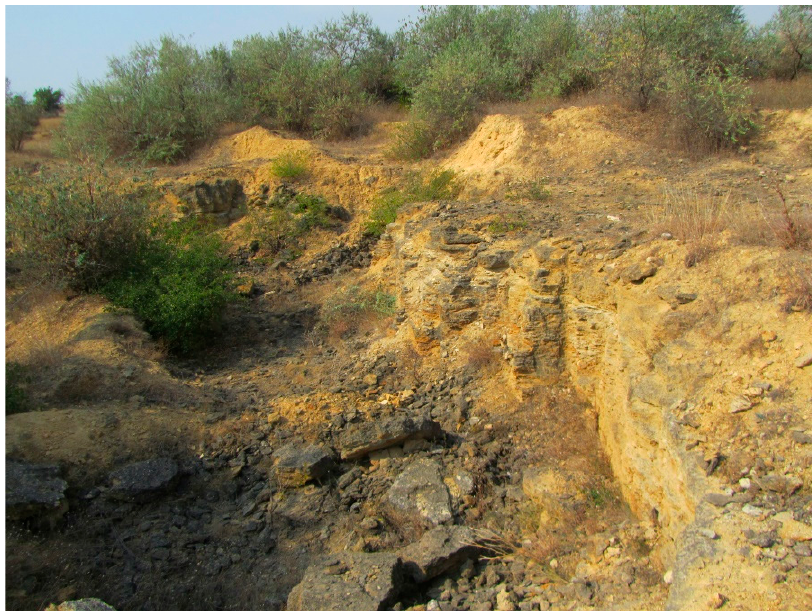
Figure 12. The coquina quarry site (surroundings of Kovalivka village). The vegetation in the territory between the water areas of the Kuyalnik Estuary and the Black Sea has undergone the greatest catastrophic changes. In historical times, it was represented by sandspits (bay bars) occupied by coastal psammophytic vegetation ( Ammophiletea , Cakiletea maritimae , and Crithmo-Staticetea ), and its flat sites were covered with halophytic vegetation ( Therosalicornietea , Festuco-Puccinellietea , Juncetea maritimi , and Bolboschoenetea maritimi ). At the beginning of the 20th century, the sandspits were built- up, and the flat areas were turned into filtration fields for water purification from oil contamination. Later, this area was transformed into a cascade of ponds separated from each other by dams. An international highway passes through this part of the valley (Figure